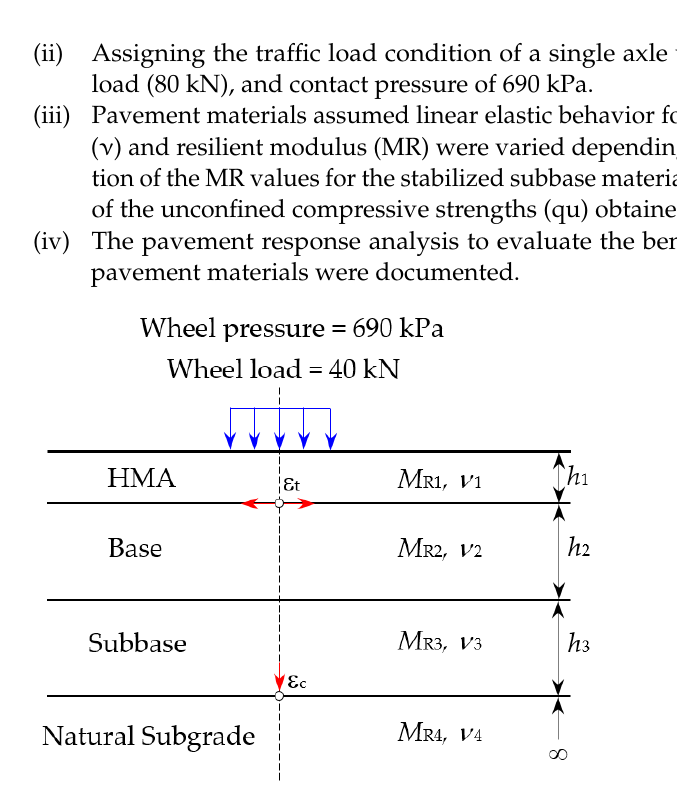
Figure 3. Pavement configuration.